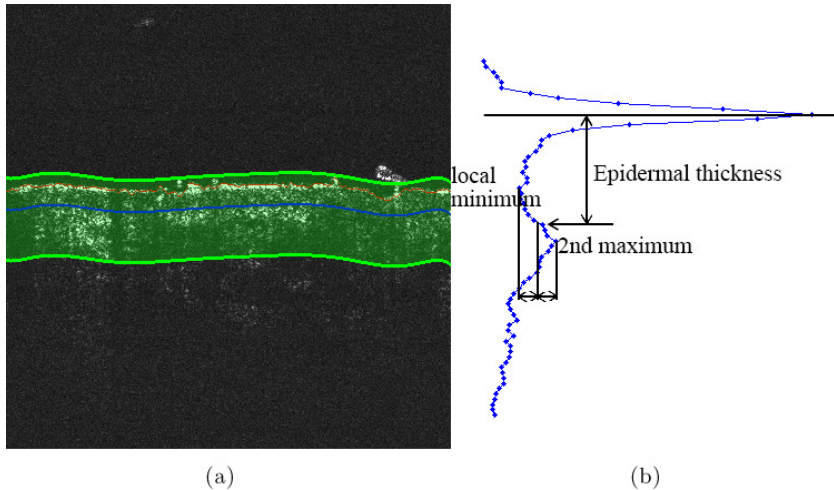
Fig. 3. ET measurement. (a) surface pro¯le. red line: air-skin surface, green line: ¯tting curve, blue line: dermal-epidermal junction (b) average A-Scan